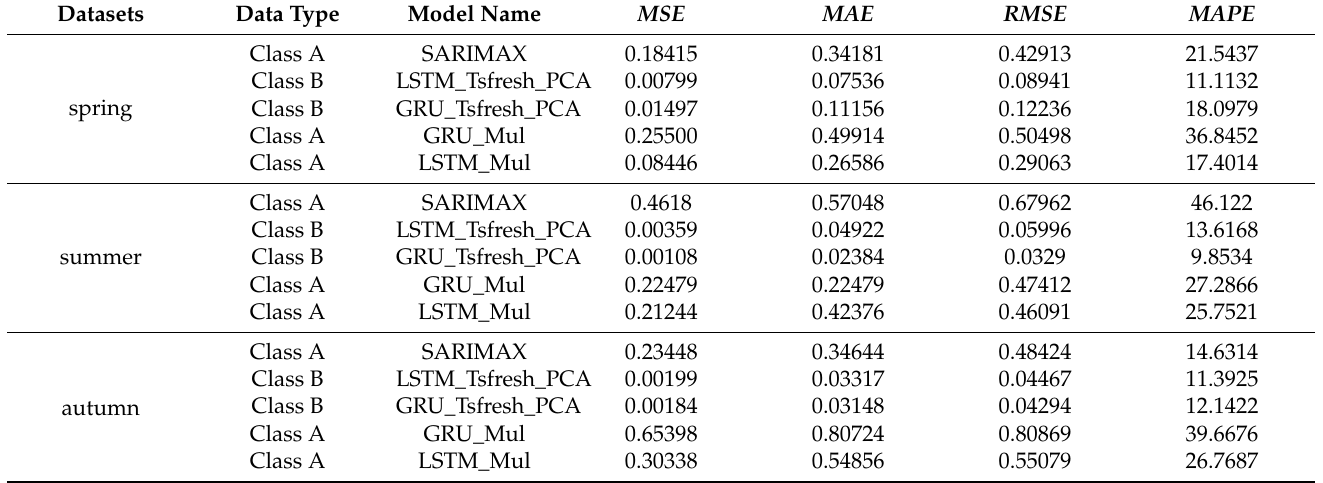
Table 5. Evaluation of the prediction results of the five